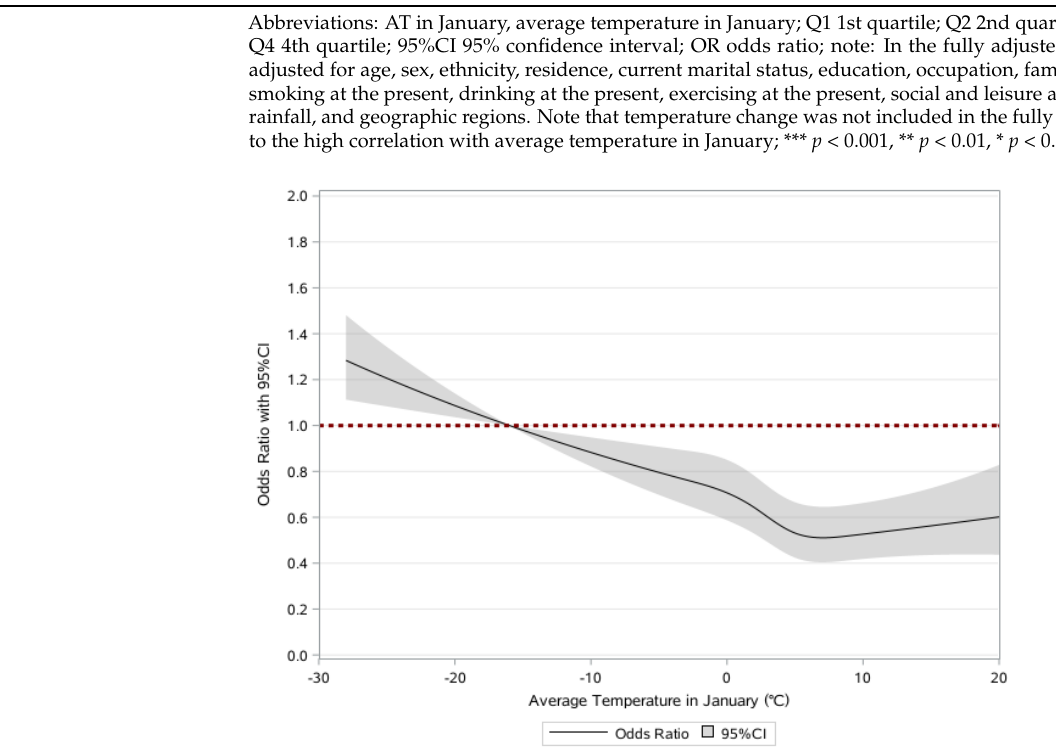
Figure 1. Restricted cubic splines for the associations between average temperature in January and frailty.